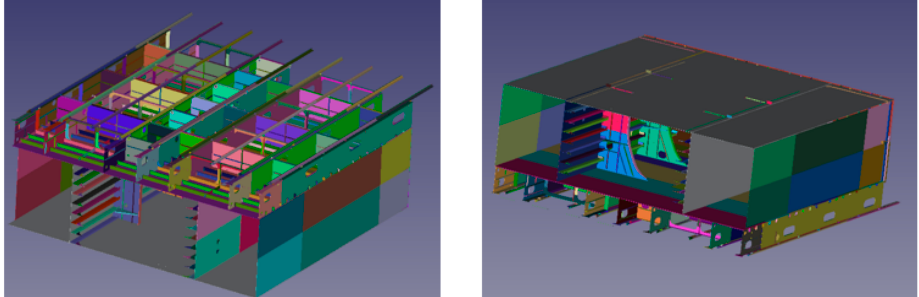
Figure 2. Computerized model of a block: Bottom ( left ) and top ( right ) iso-views.